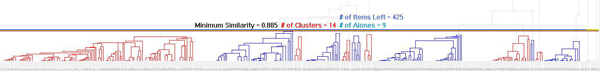
Functional clustering (molecular function) of Clus2300 of mouse genome. Table 5 provides the details on functional cohesiveness.